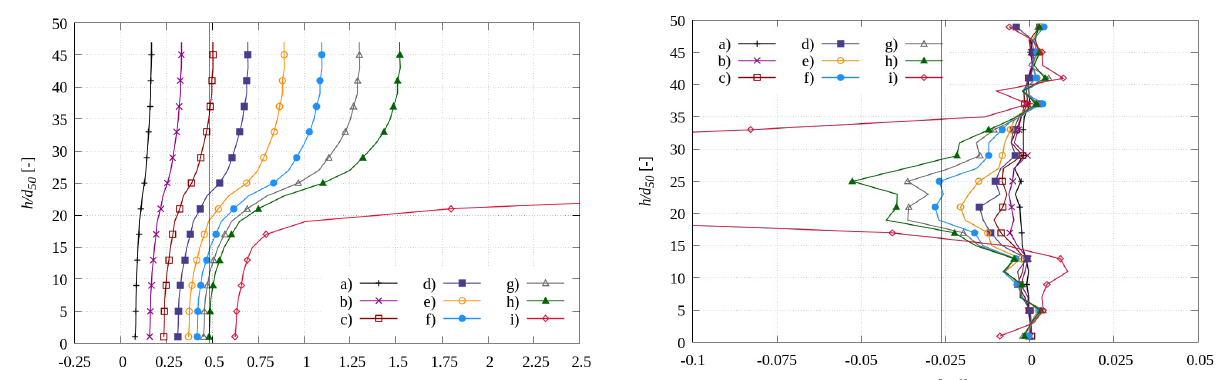
Figure 21: Distribution of sphere rotations ω across the normalized specimen height h / d at the specimen centre for: a) u 50 b) u = 0.50 mm, c) u = 0.75 mm, d) u = 1.00 mm, e) u x x x u = 1.50 mm, g) u = 1.75 mm, h) u = 2.00 mm and i) u x x x ( e = 0.60, σ = 200 kPa, d = 0.5 mm) (negative value corresponds 0 0 50 to the clockwise rotation; dark vertical line demonstrates 5%